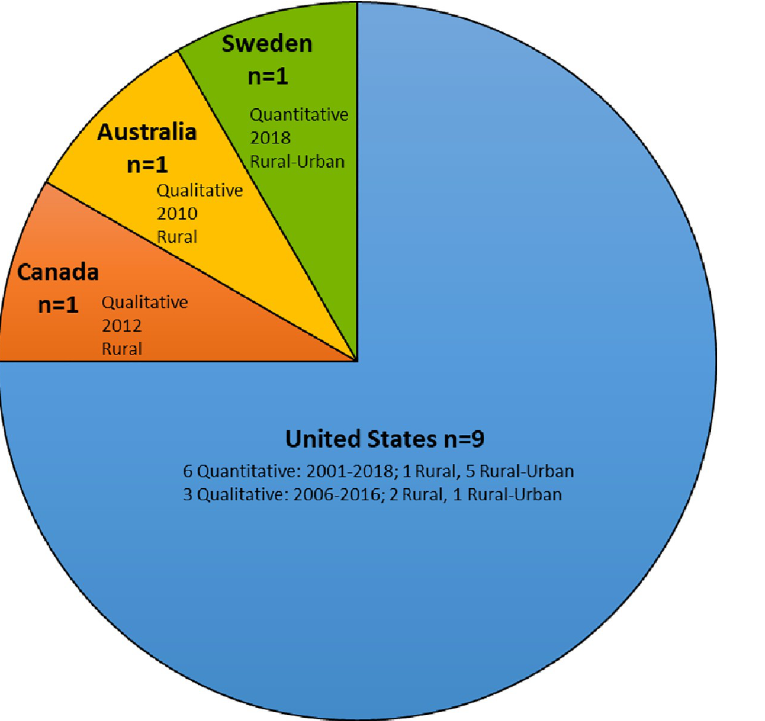
Fig 2. Characteristics of included peer-reviewed